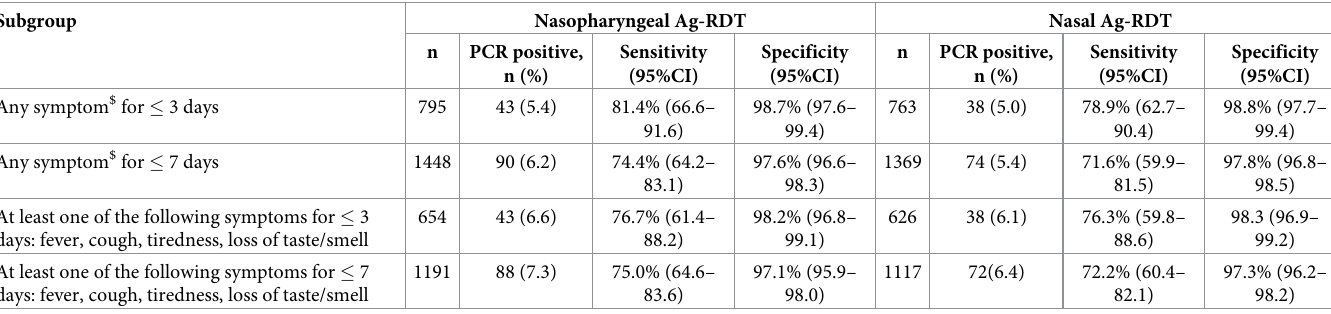
we used two different PCR platforms as reference standard, ABI 7500 and Xpert Xpress SARS-CoV-2. Both platforms are, however well validated with comparable sensitivity and specificity [26]. Further, the study was conducted when the B.1.617.2 (Delta Variant) was dominant in Southern Africa. Diagnostic accuracy of the Ag-RDT may be different in other Table 2. Sensitivity and Specificity of Ag-RDT on nasopharyngeal and nasal samples as compared to nasopharyngeal PCR in different